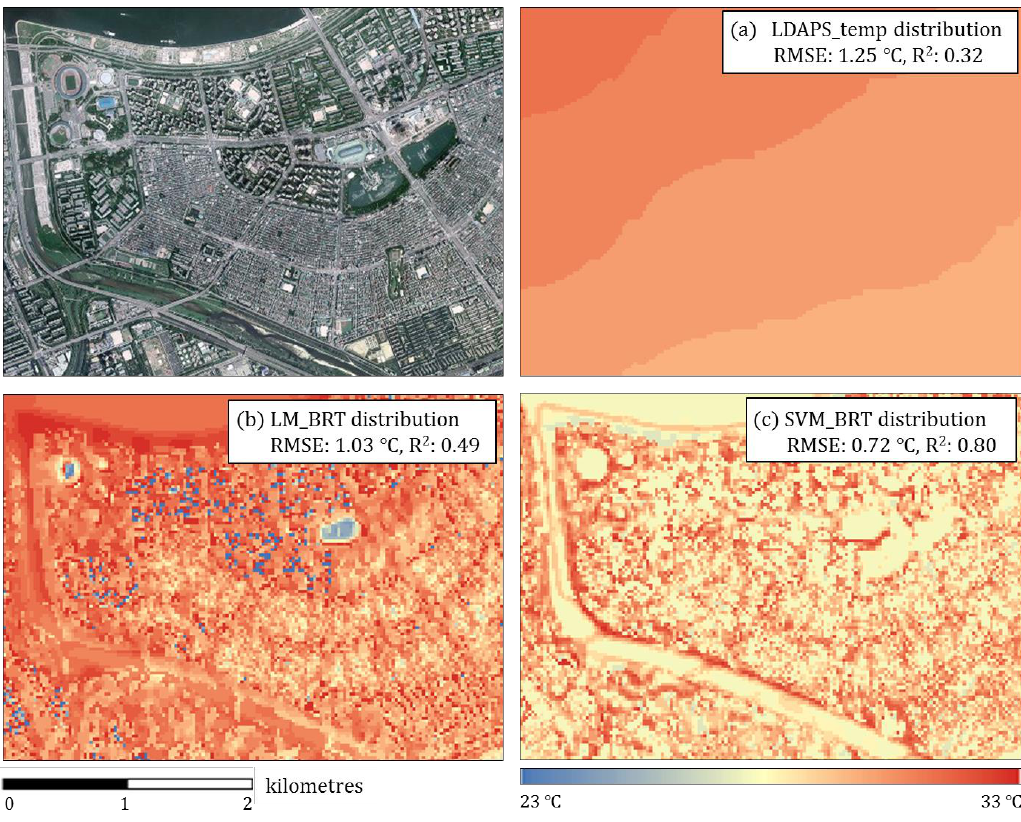
Figure 9. Aerial photography and BRT distribution of daily maximum temperatures estimated in the Songpa area of Seoul on 30 August 2015.